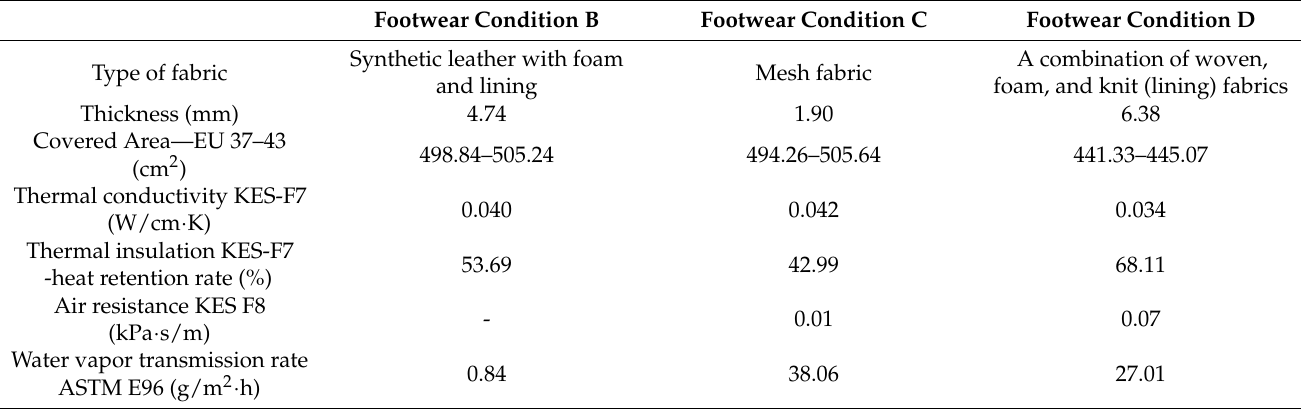
Figure 1. Four experimental conditions: Condition ( A ), barefoot; Footwear Condition ( B ), leather sports shoe; Footwear Condition ( C ), mesh sports shoe; and Footwear Condition ( D ), closed-toe slipper. Table 1. Upper material properties of footwear conditions.